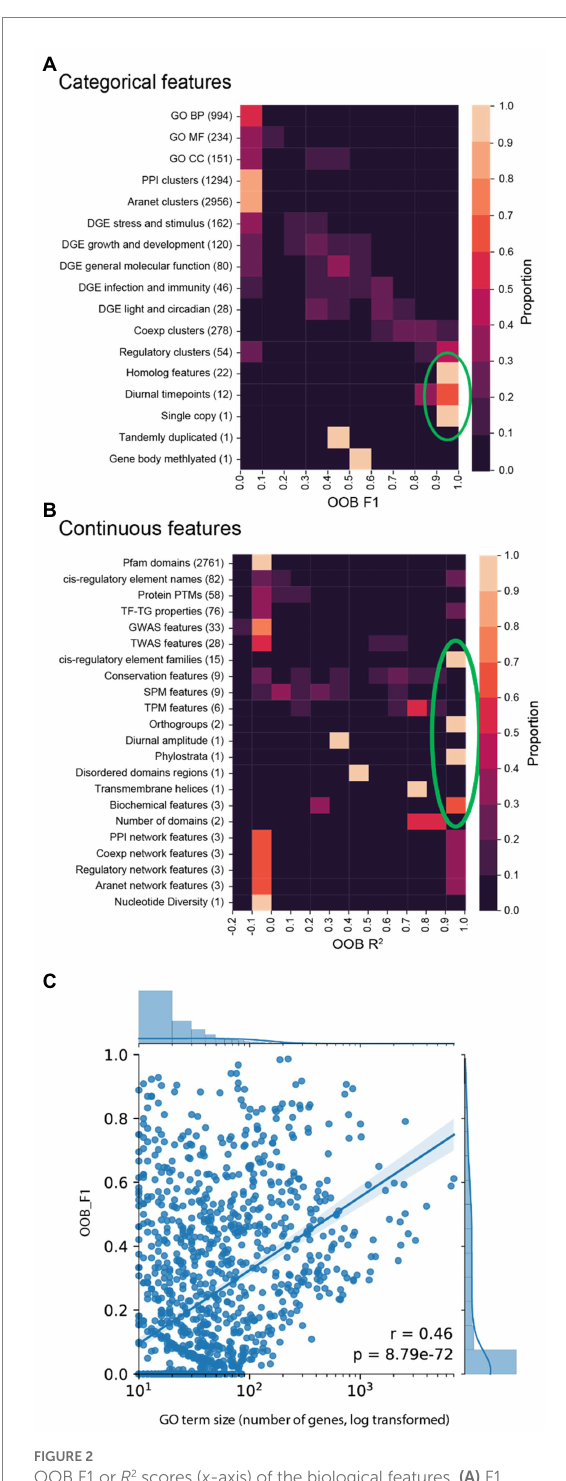
FIGURE 2 OOB F1 or R 2 scores ( x -axis) of the biological features. (A) F1 scores ( x -axis) for categorical features ( y -axis). (B) R 2 continuous feature scores. (C) F1 scores ( y -axis) of GO terms vs. number of genes in each GO term ( x